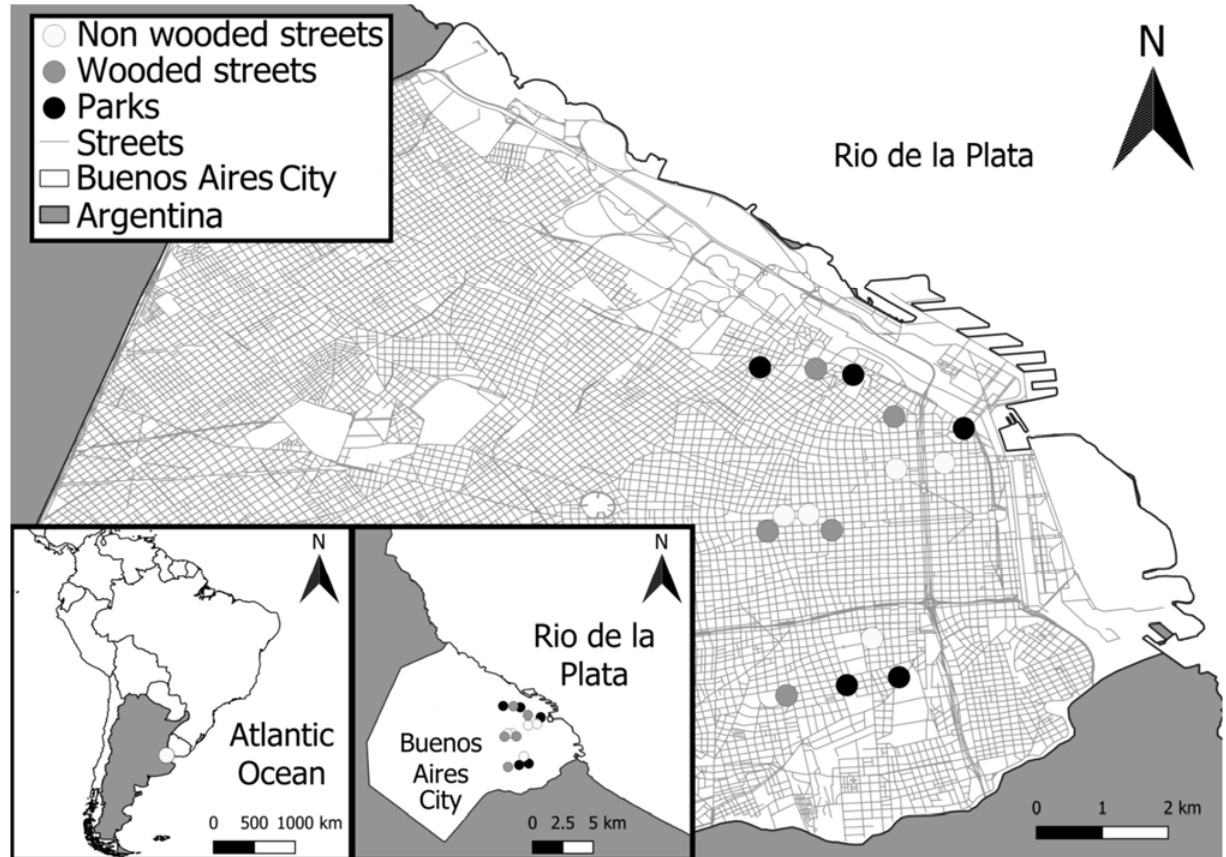
Figure 1. Location of the transects within Buenos Aires city, Argentina.